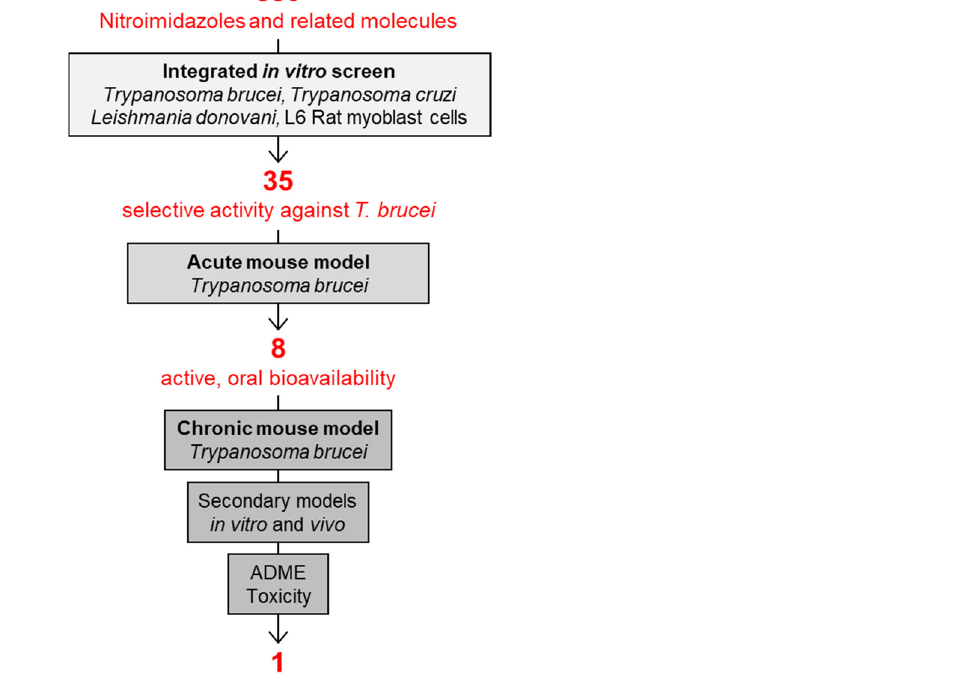
Figure 3. The HAT-pipeline at Swiss TPH established by the Parasite Chemotherapy Unit under the lead of Reto Brun. The one molecule that was singled out as the best drug candidate of all the tested nitro-drugs was fexinidazole.